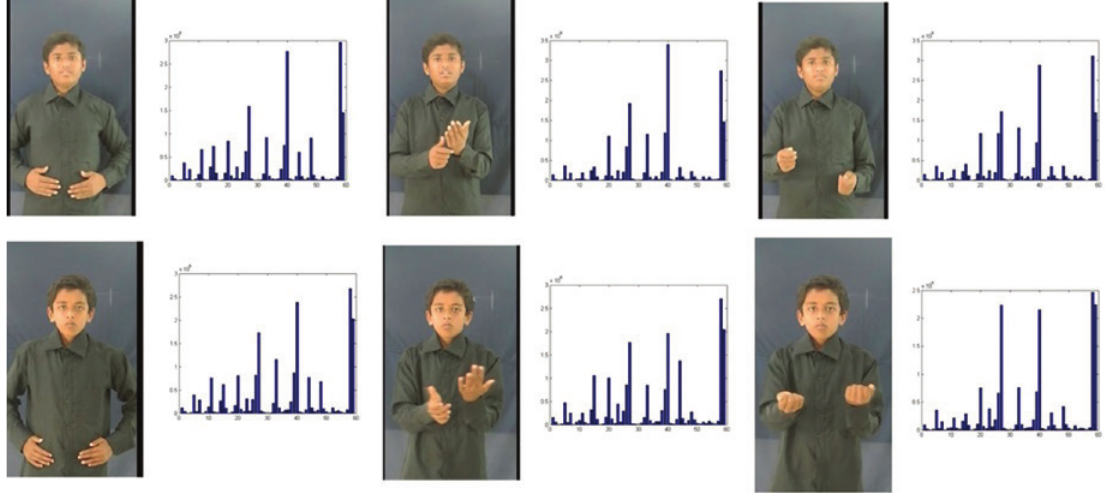
Figure 2: LBPV Histograms for Two Different Users of the Sign “I Want Bus